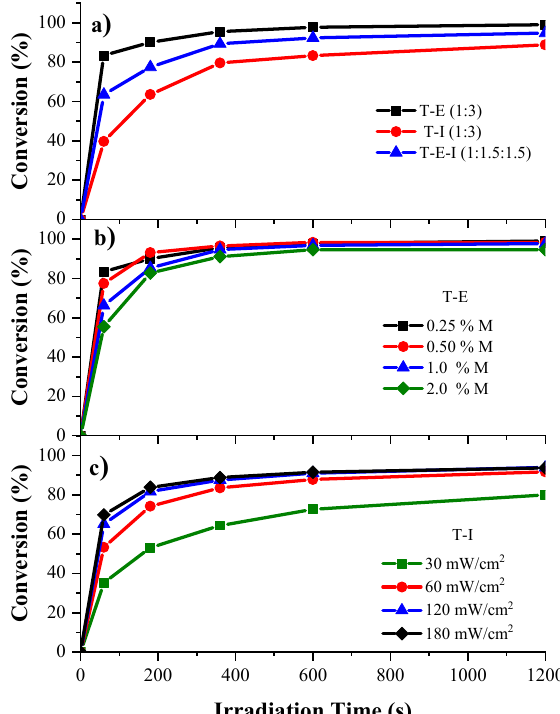
Figure 4. Kinetics of photopolymerization of the acrylate HIPEs using the gravimetry technique: ( a ) comparison of the reactivity of the formulations T–E (1:3), T–I (1:3) and T–E–I (1:1.5:1.5) at 0.5 mol% of DMPA and 0.5 mol% of BAPO at 30 mW/cm 2 of UV-Vis light intensity; ( b ) effect of the concentration of the mixture of photoinitiators DMPA:BAPO on T–E formulation at 60 mW/cm 2 ; ( c ) effect of the UV-Vis light intensity on the photopolymerization rate of the formulation T–I at 0.5% mol of